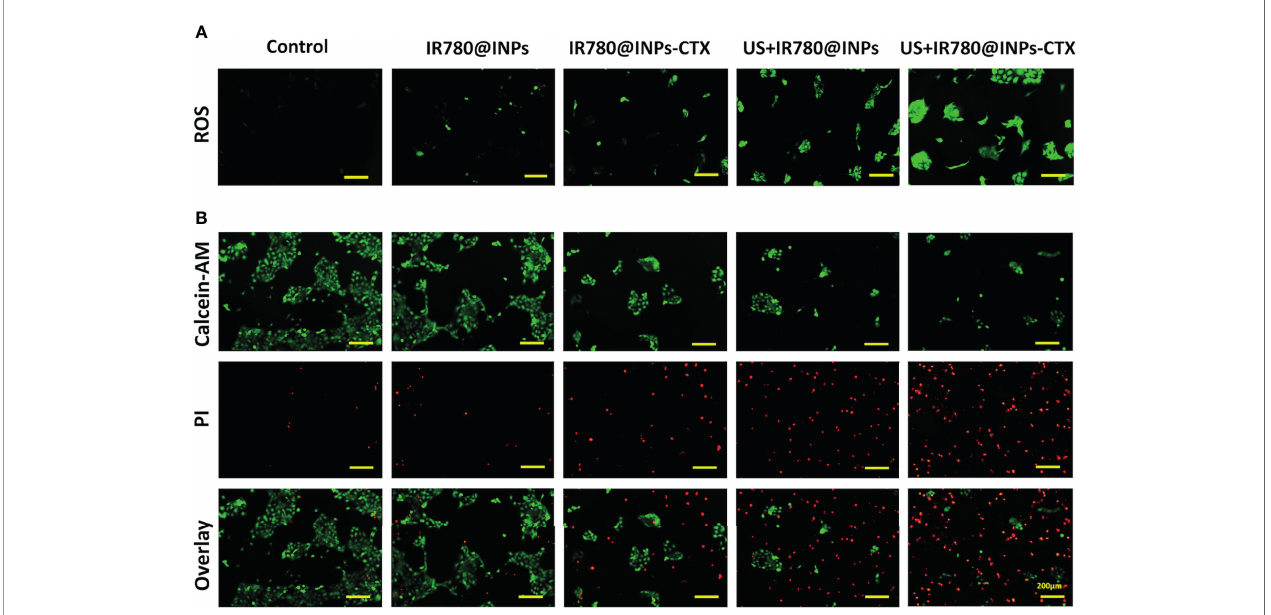
FIGURE 3 | (A) ROS levels of HCC827 cells in the fi ve groups. (B) In different groups, each group of cells is stained with Calcein-AM and PI, and the living cells are green fl uorescent, and dead cells are red fl